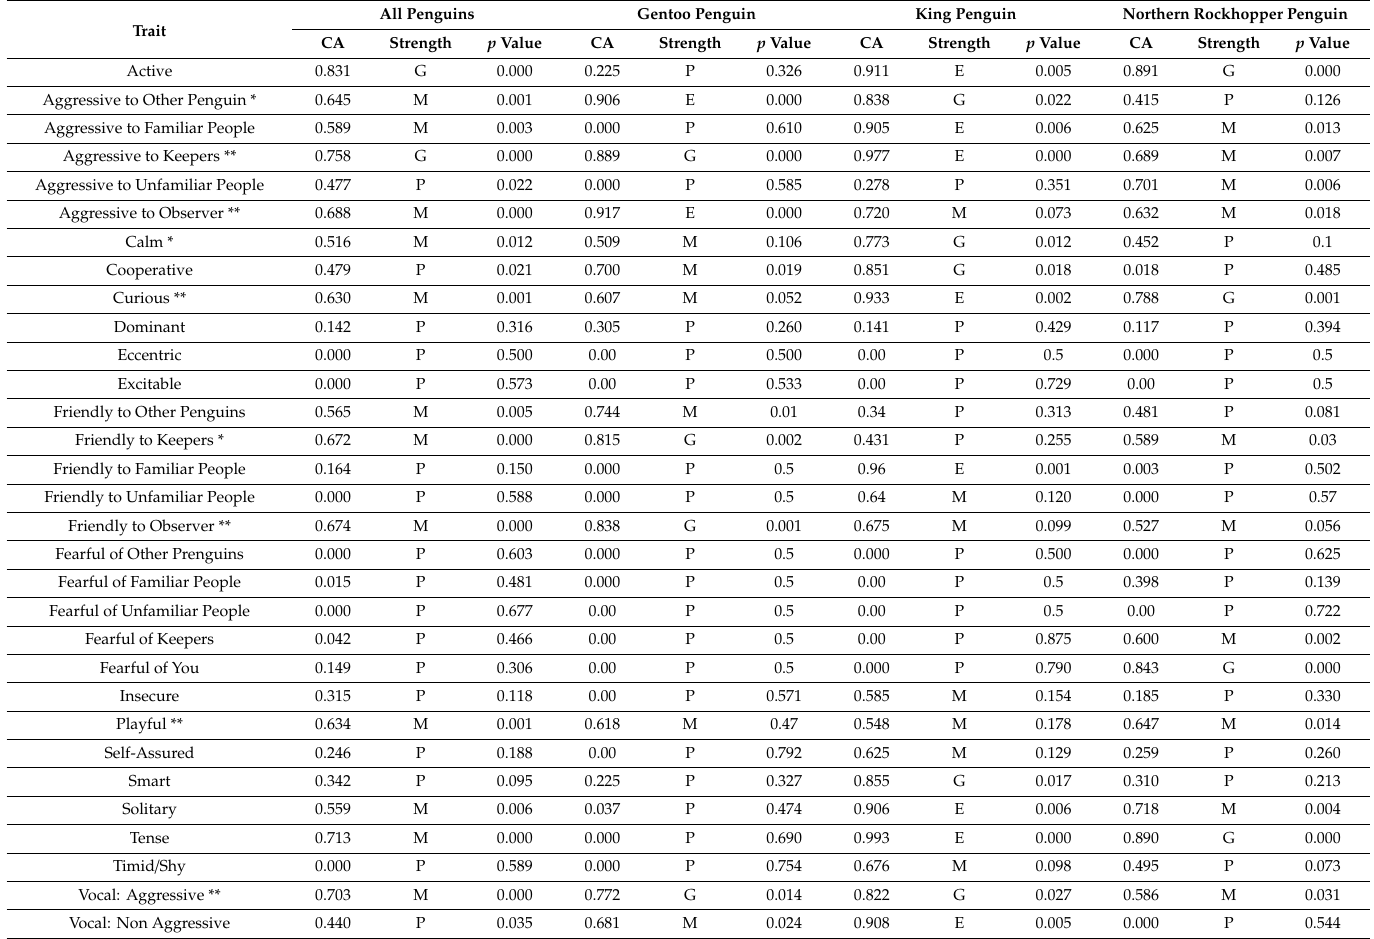
Table 1. The table comprises Cronbach’s alpha coe ffi cient values (CA), calculated for all penguins together (all penguins) and divided by species. The coe ffi cients are classified as “poor” (P), “moderate” (M), “good” (G) and “excellent” (E). p < 0.05 values are considered as statistically di ff erent. * and ** = trait considered in the subsequent Multivariate analysis of personality variables: * CA value > 0.5 in at least two species of the three considered; ** CA value > 0.5 in all the three species